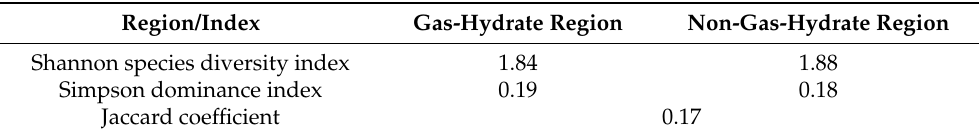
Table 3. Values of the main diversity indices in the studied areas of the northern part of the Sea of